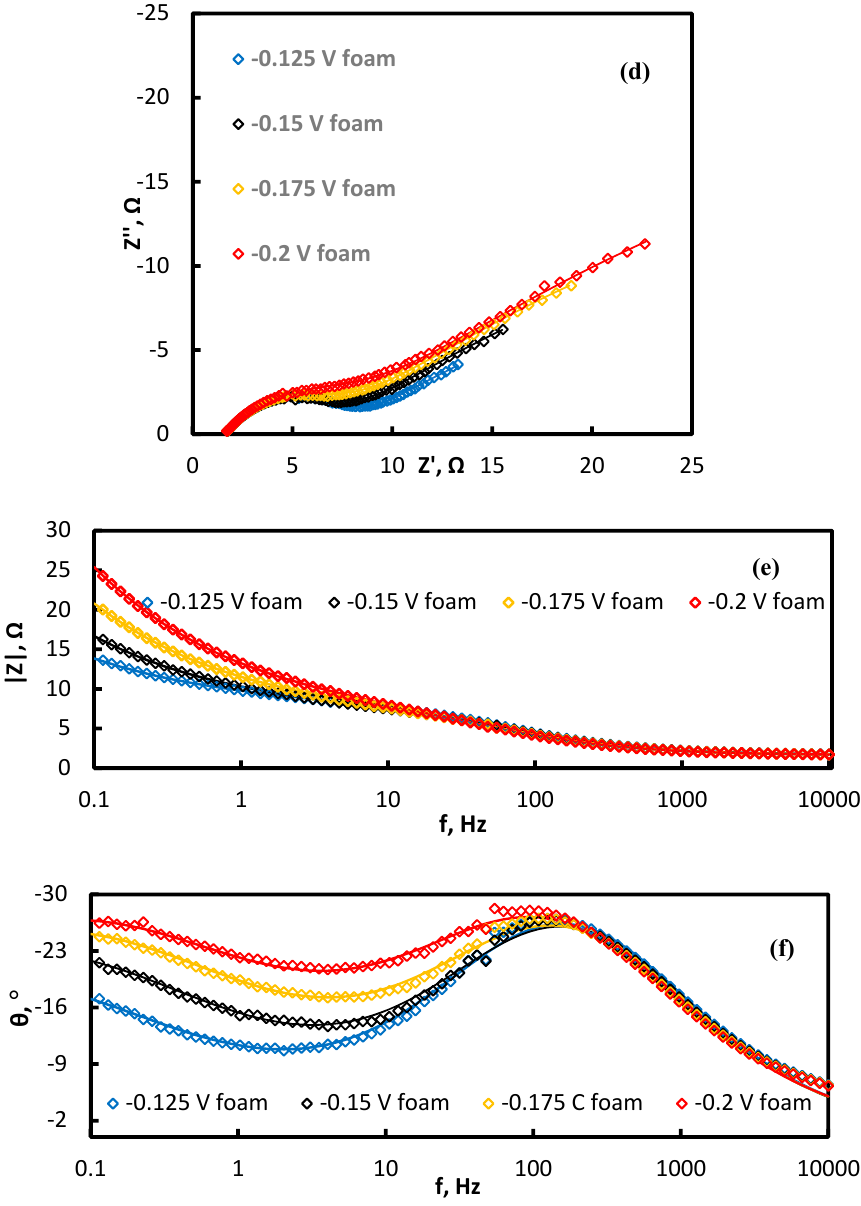
Figure 4. Nyquist ( a , d ) and Bode plots ( b – c , e – f ) on Cu plate ( a – c ) and foam ( d – f ) registered at various potentials (indicated on graphs) in 0.1 M CuSO 4 + 0.4 M Na 2 SO 4 solution at 20 °C. Points—experimental data, solid lines—results of fitting to equivalent electric circuit (EEC) shown in the inset ( a ).